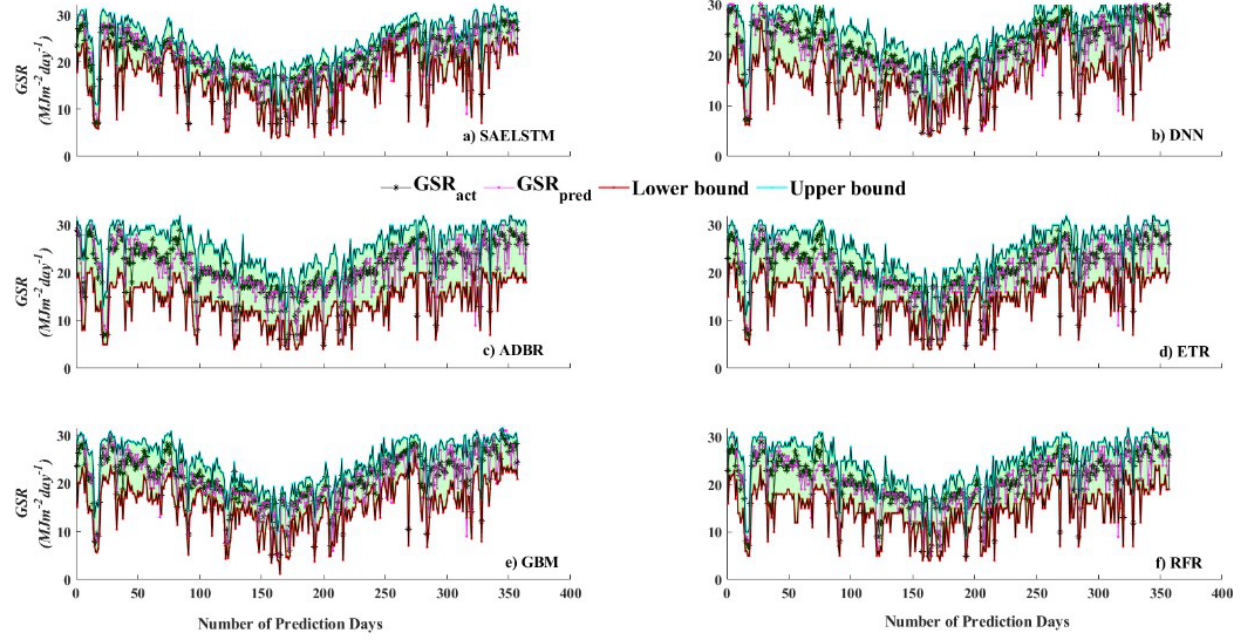
Figure 12. A comparative result showing the upper bound and lower bound for the 90% prediction interval between the proposed SAELSTM and other comparative